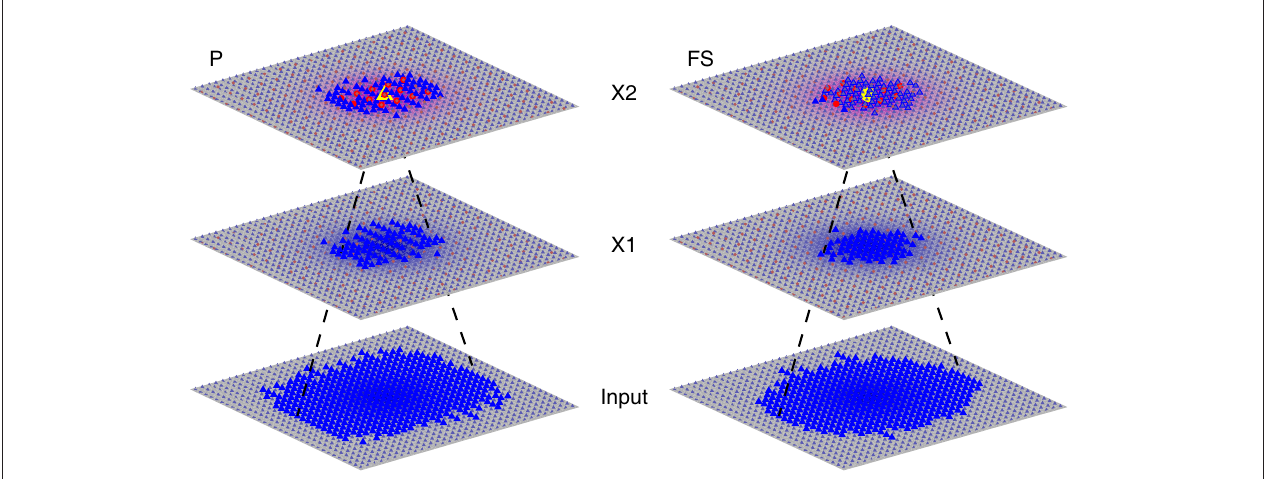
Figure 1 | Model architecture and connectivity. Connectivity is shown for one pyramidal (P) cell (left) and one fast-spiking inhibitory (FS) cell (right) in X2 (marked in yellow). Blue triangles represent P cells, red circles represent F cells. Both cells types connect to both cells types locally within each stage and receive input from a pool of excitatory cells from the previous stage.